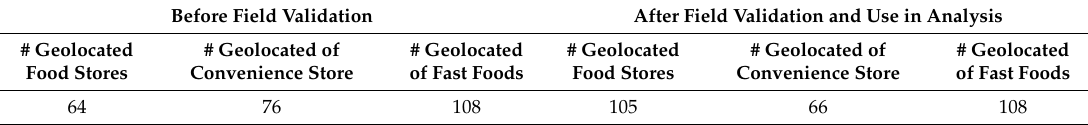
Table 1. Number of food stores before and after the field validation process. Before Field